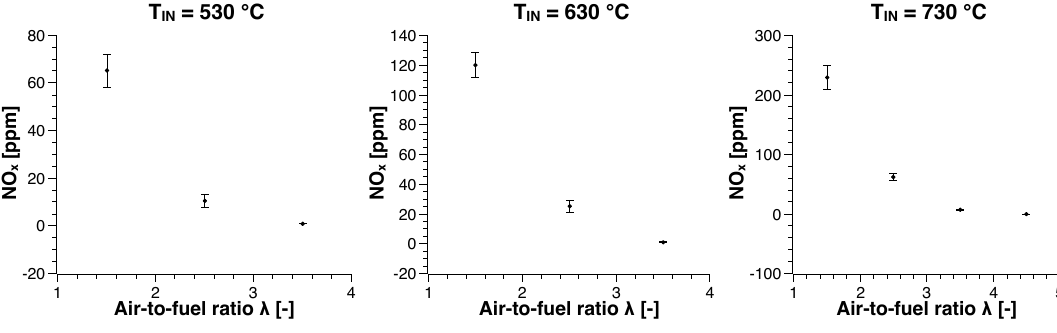
Figure 6. NO x concentration (ppm) in the exhaust gases, normalized at 15% O 2 , as a function of the air-to-fuel ratio λ for different values of the air inlet